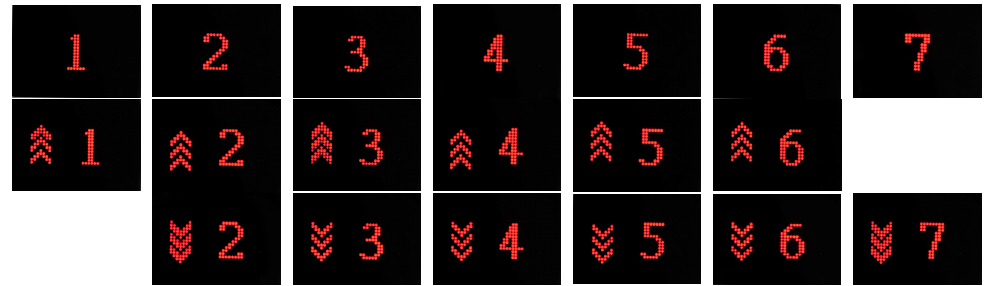
Figure A4. Images displayed on panel in the elevator car.